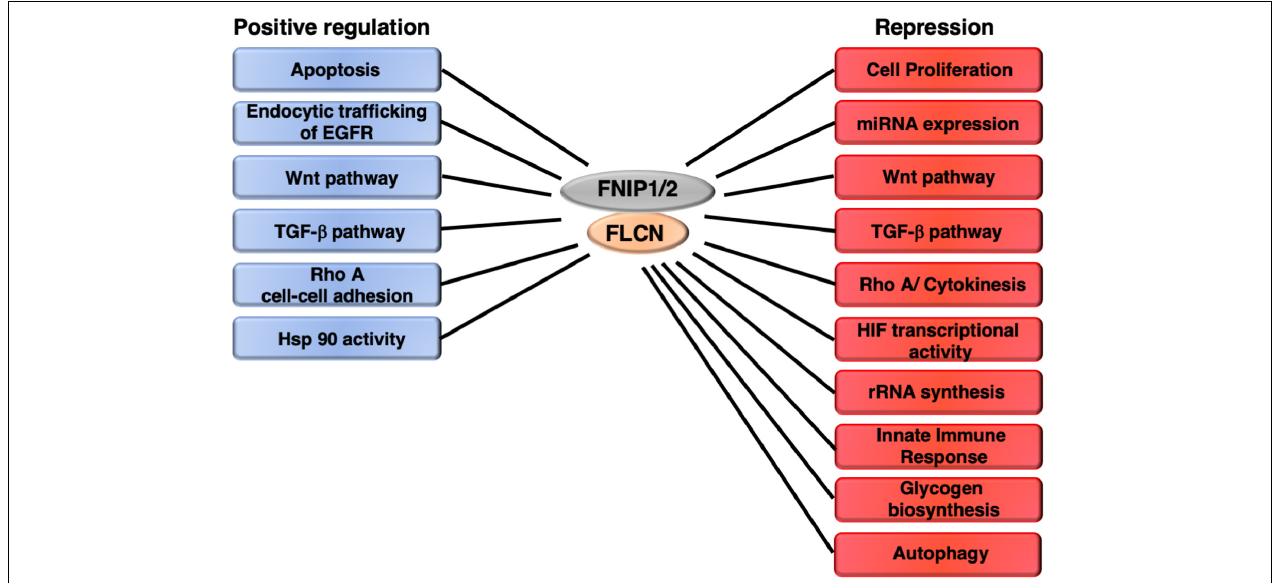
FIGURE 4 | Other pathways and cellular processes regulated by FLCN/FNIP independently of AMPK and mTORC1. FLCN shows an opposing effect on certain pathways depending on the cellular